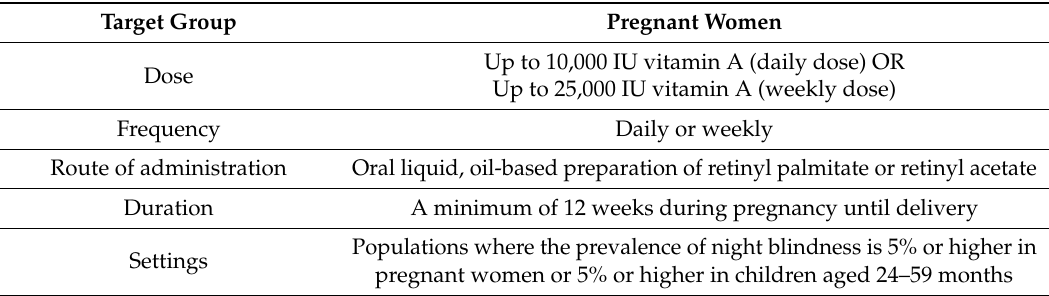
Table 2. Suggested vitamin A supplementation scheme in pregnant women for the prevention of night blindness. Target Group Pregnant Women Up to 10,000 IU vitamin A (daily dose) OR Dose Up to 25,000 IU vitamin A (weekly dose) Frequency Daily or weekly Route of administration Oral liquid, oil-based preparation of retinyl palmitate or retinyl acetate Duration A minimum of 12 weeks during pregnancy until delivery Populations where the prevalence of night blindness is 5% or higher in Settings pregnant women or 5% or higher in children aged 24–59 months IU: international units. Source: Reference